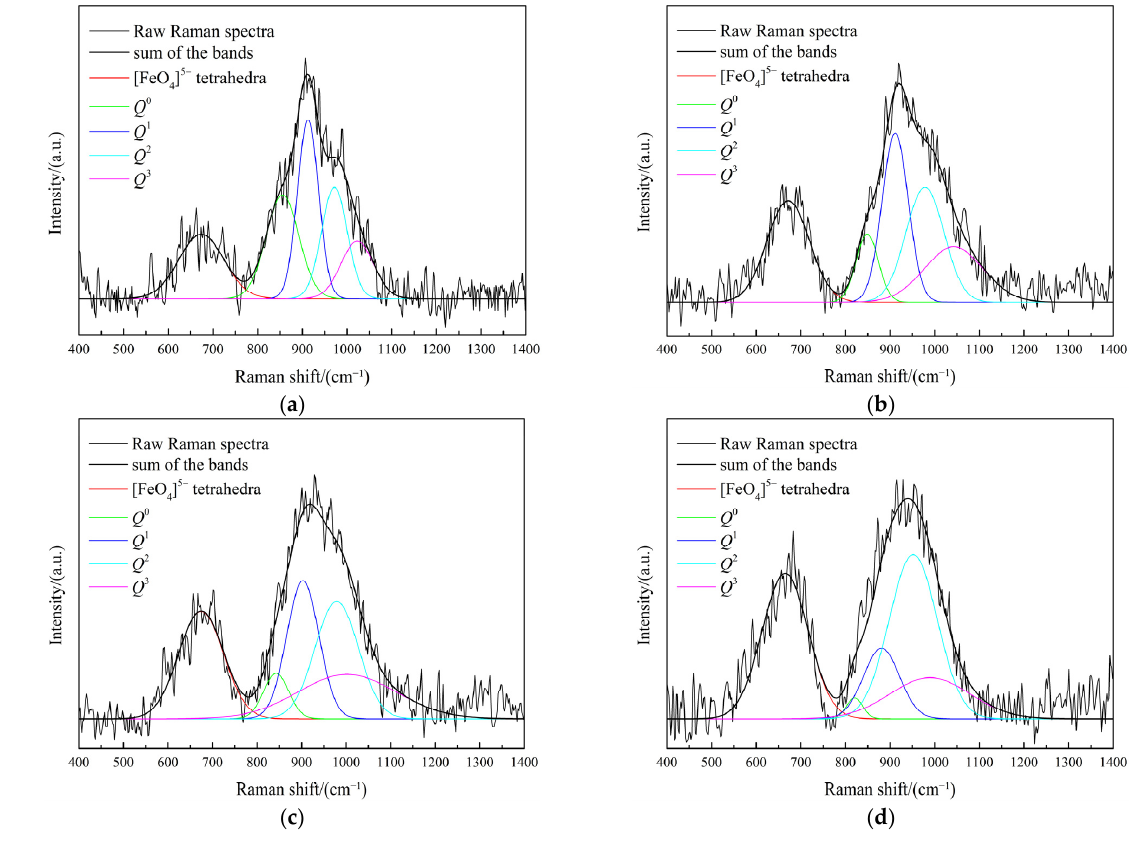
Figure 13. Deconvolution of Raman spectra of quenched slags at fixed Fe/SiO 2 ratio of 1.2 with various Fe 2 O 3 levels of ( a ) 4 wt%; ( b ) 8 wt%; ( c ) 12 wt%; ( d ) 16 wt%.